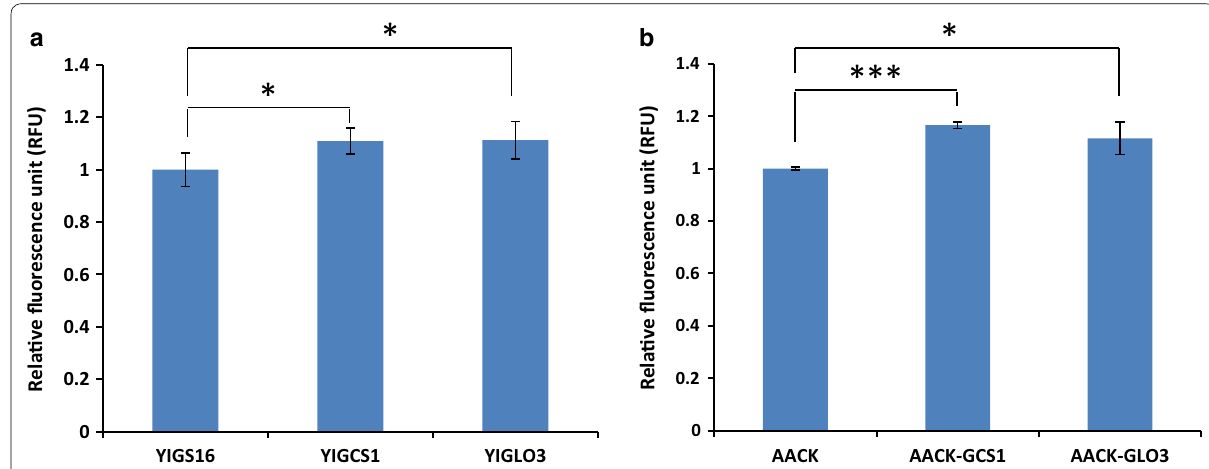
Fig. 2 The amounts of ER membrane of strains a YIGS16, YIGCS1 and YIGLO3. b AACK, AACK-GCS1 and AACK-GLO3 using ER-Tracker Blue-White DPX. The ER membrane changes were quantified by their fluorescence intensity. *P < 0.05; ***P < 0.001. Measurements are reported as the average value standard deviation from independent ±